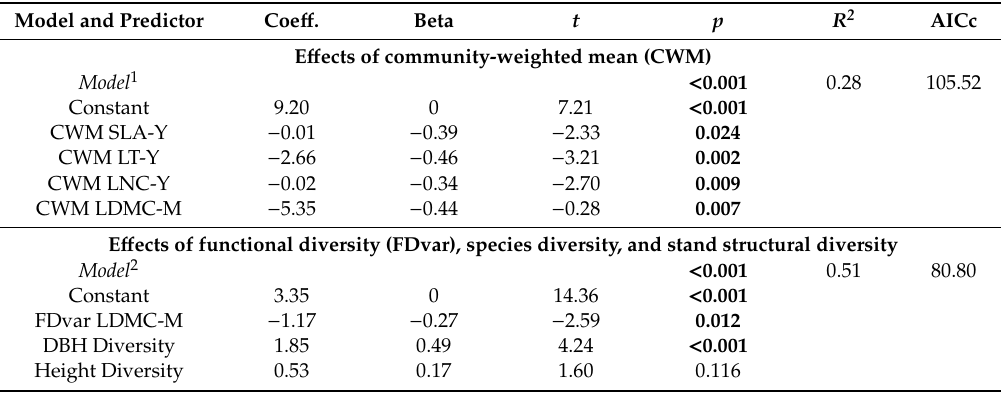
Figure 3. Significant bivariate relationships between aboveground carbon storage (AGC) and predictor variables ( n = 56). CWM, community-weighted mean; LNC-Y, young leaf nitrogen concentration; DBH Diversity, diameter at breast height diversity; FDvar, functional diversity; LDMC-Y, leaf dry matter content of young leaf; LDMC-M, leaf dry matter content of mature leaf; LPC-Y, leaf phosphorus concentration of young leaf; SLA-Y, specific leaf area of young leaf; SLA-M, specific leaf area of mature leaf. Table 3. The optimal model resulted from a sequence of regression analyses of aboveground carbon storage. The regression coe ffi cient (Coe ff .), the standardized regression coe ffi cient (Beta), the t -test, and the p -value are given for each predictor variable. For the model, the coe ffi cient of determination ( R 2 ), the p -value, and the Akaike Information Criterion (AICc) are also given. p -values of < 0.05 are in